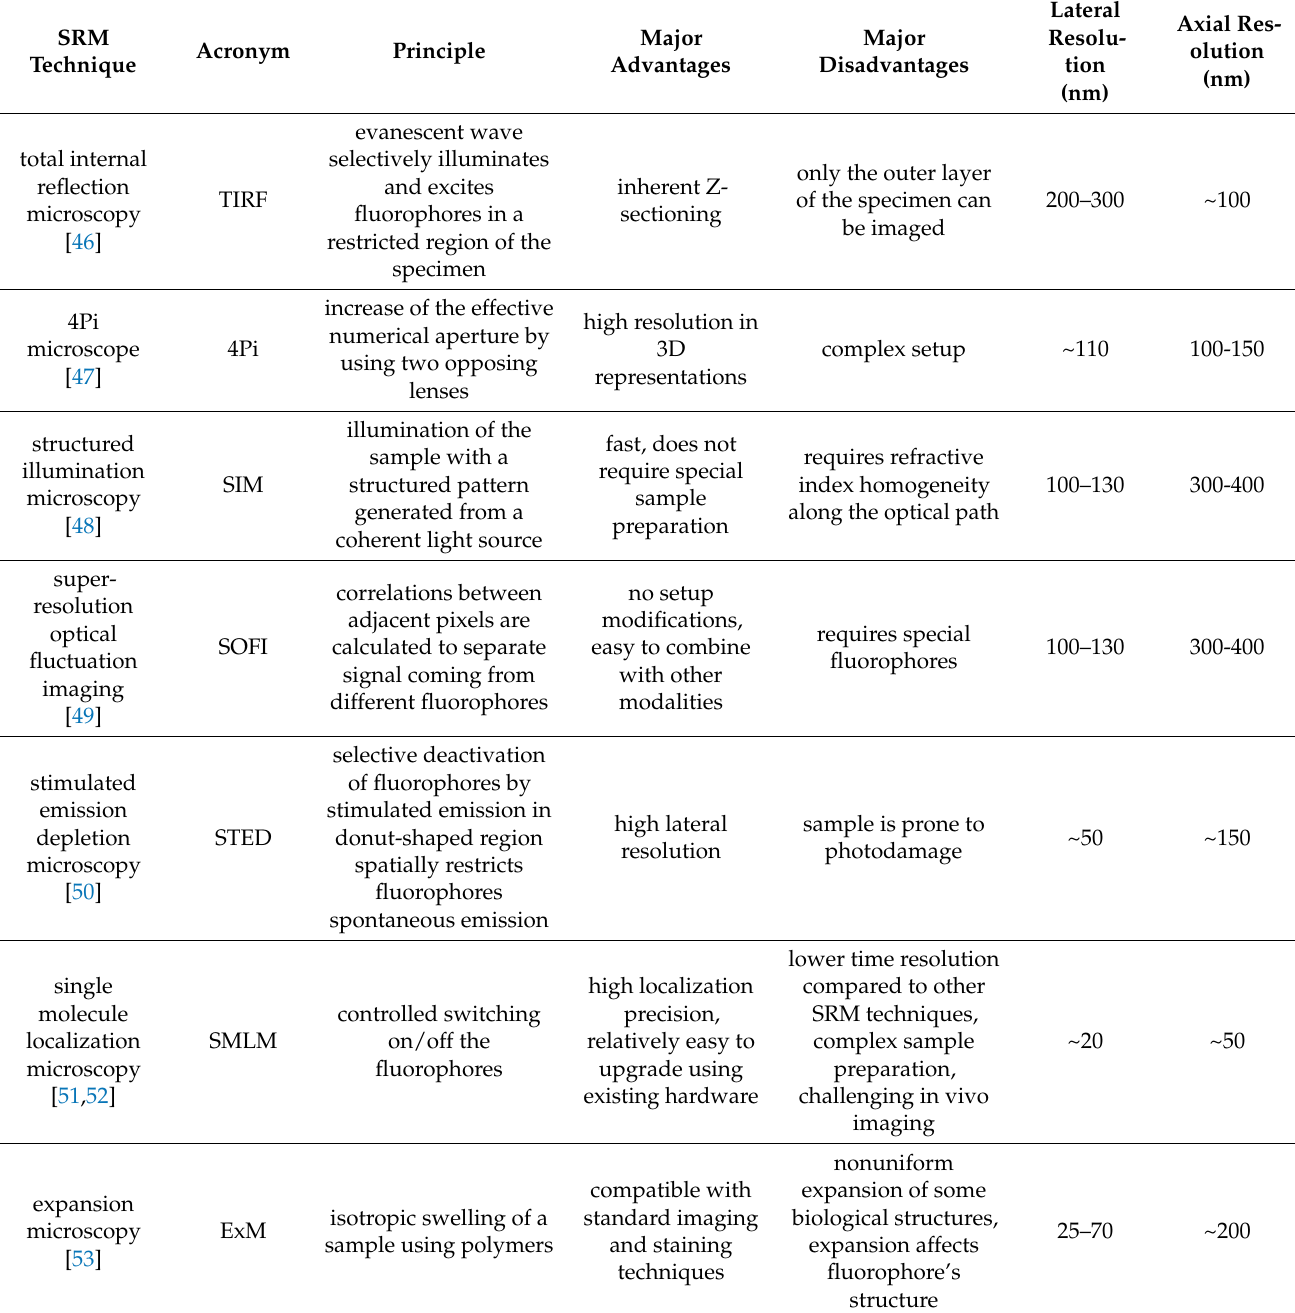
Table 1. Summary of the selected SRM